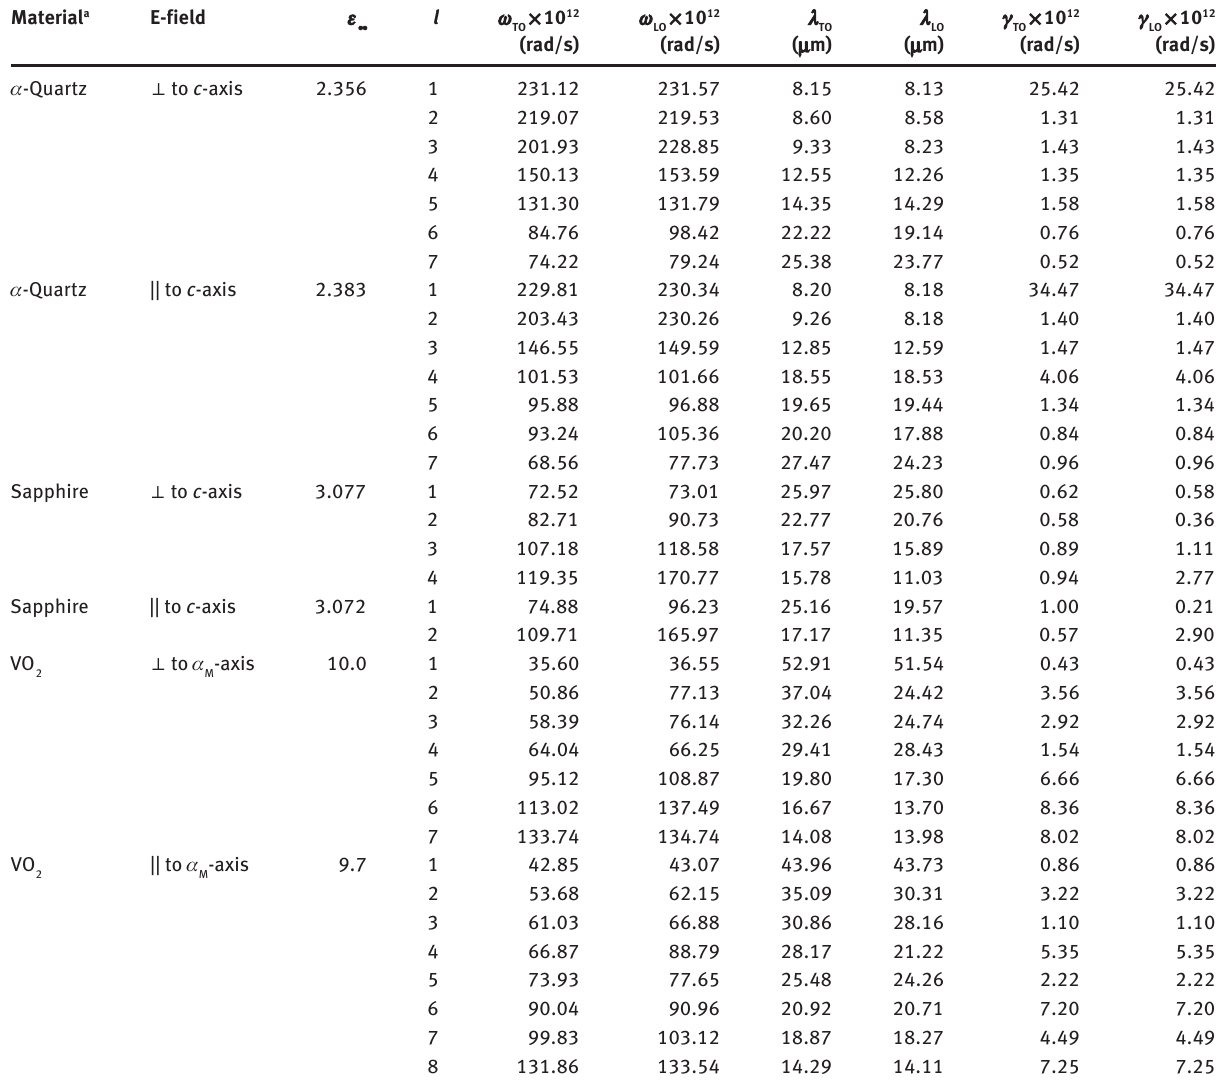
Table 4: Anisotropic PhP responses of some widely used photonic